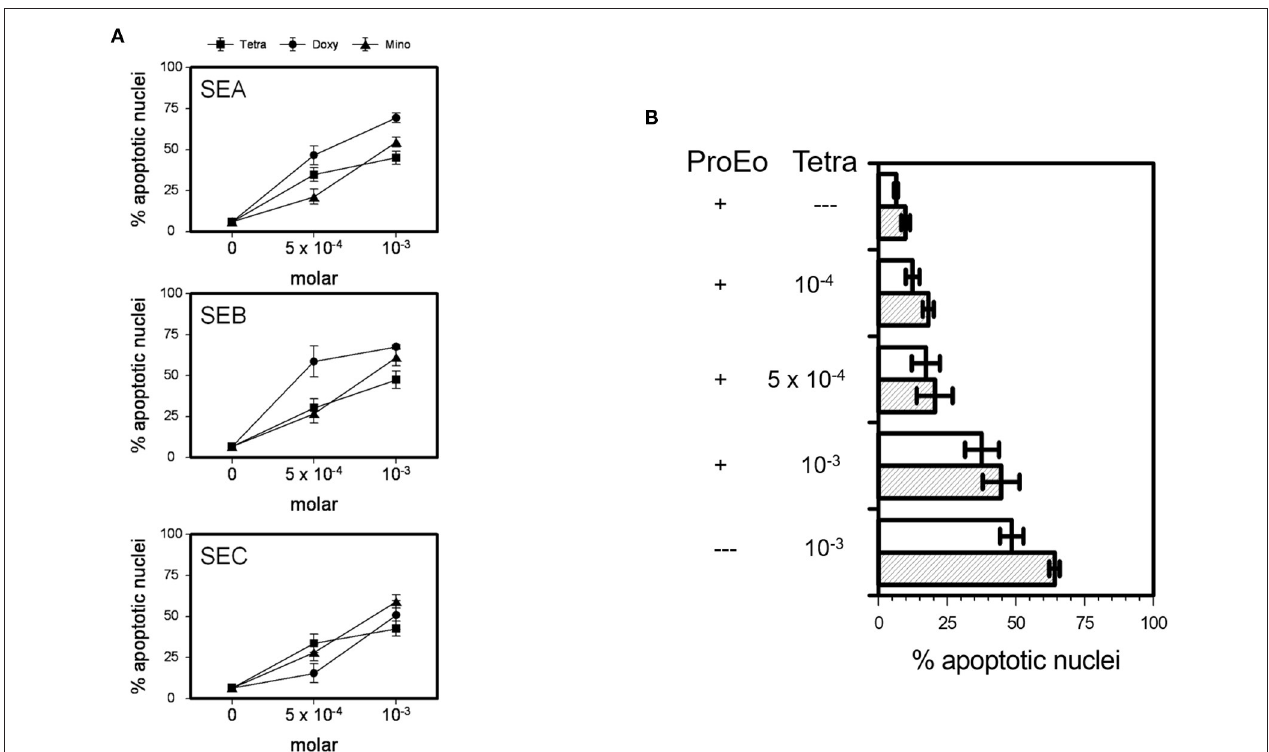
FIGURE 4 | TCNs overcame the survival prolonging effects of SEA, SEB, SEC, and of key pro-survival eosinophil cytokines, i.e., a mixture of IL-3, IL-5, and GM-CSF (ProEo). (A) Co-incubation of 5 × 10 − 4 M or 10 − 3 M tetracycline hydrochloride (Tetra), doxycycline (Doxy), or minocycline (Mino) wit SEA, SEB, and SEC (5 µ g/ml each; p < 0.05 up to p < 0.001 vs. medium control = 0). Data are presented as percentage of apoptotic nuclei ± SEM ( n = 6). (B) Tetra partly abrogated the effect of ProEo. Mean percentage of apoptotic nuclei ± SEM ( n = 5) after stimulation for 24h (unfilled bars) and 48h (striped bars). P < 0.05 up to p < 0.001.